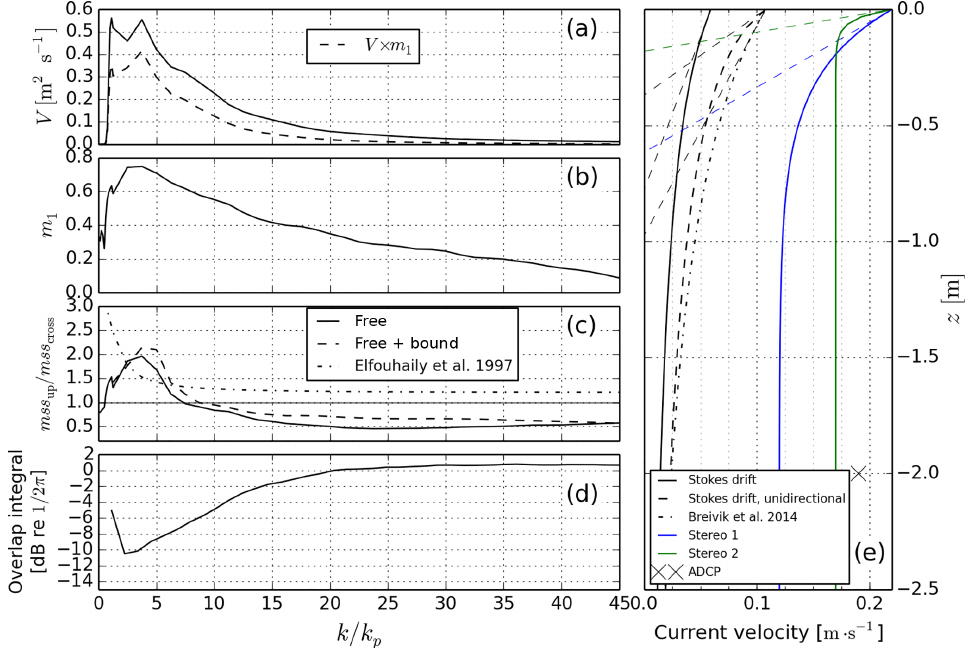
Figure 6. Short wave contribution to various sea state variables. (a) Spectrum of non-directional Stokes drift, Eq. (24). (b) Stokes drift directional correction, Eq. (23). (c) Mean square slope up-wind over cross-wind ratio, Eqs. (30) and (31). (d) Overlap integral, Eq. (34). (e) Near-surface current profiles (see Appendix), with the two-parameter exponential integral profile of Breivik et al. (2014, their Eq.